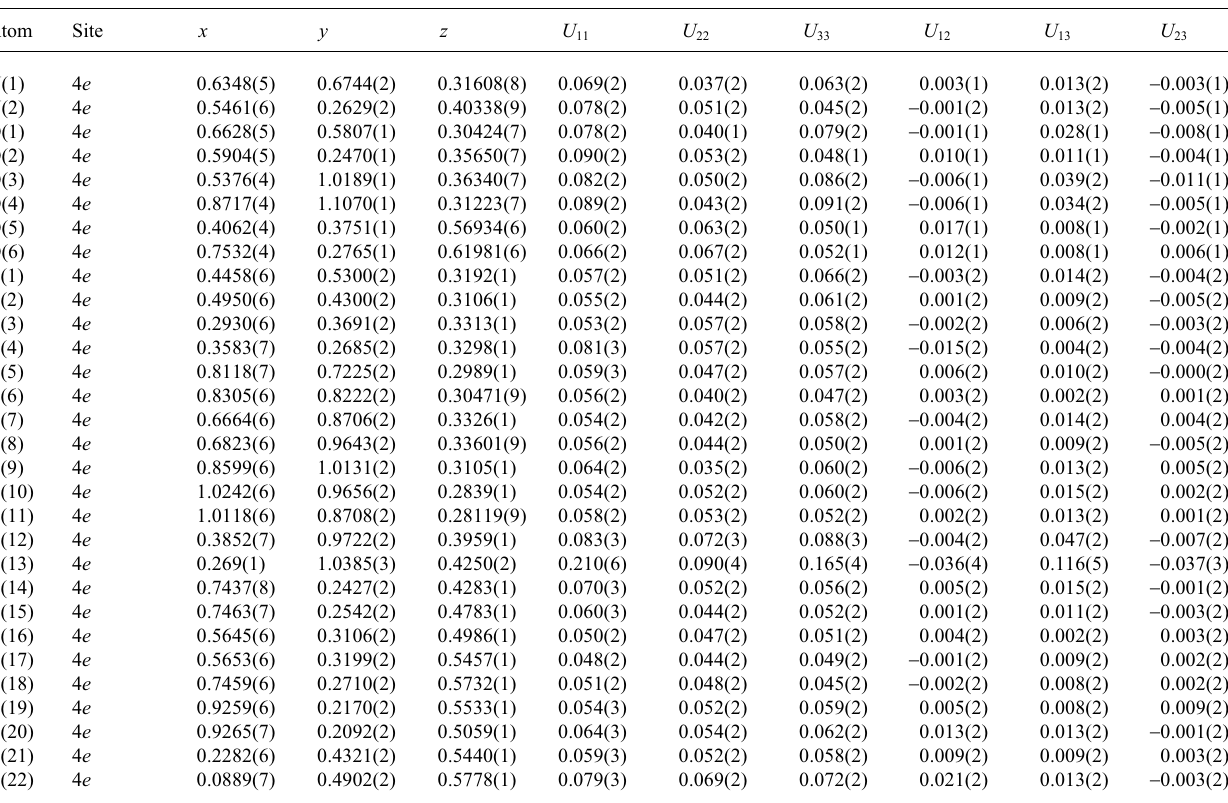
Table 3. Atomic coordinates and displacement parameters (in Å 2